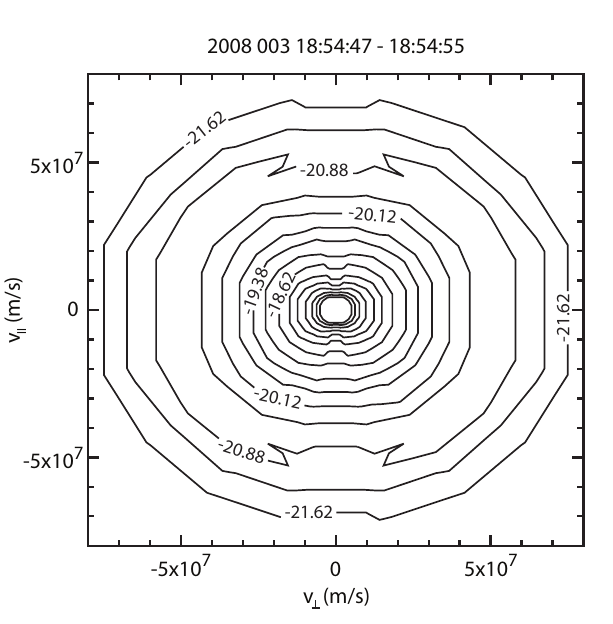
Fig. 11a. Contours of the electron phase space density for the period